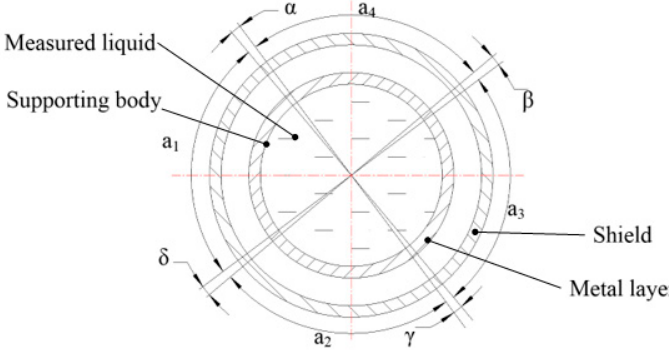
Figure 1. Principle of cross-capacitive liquid-level sensor.